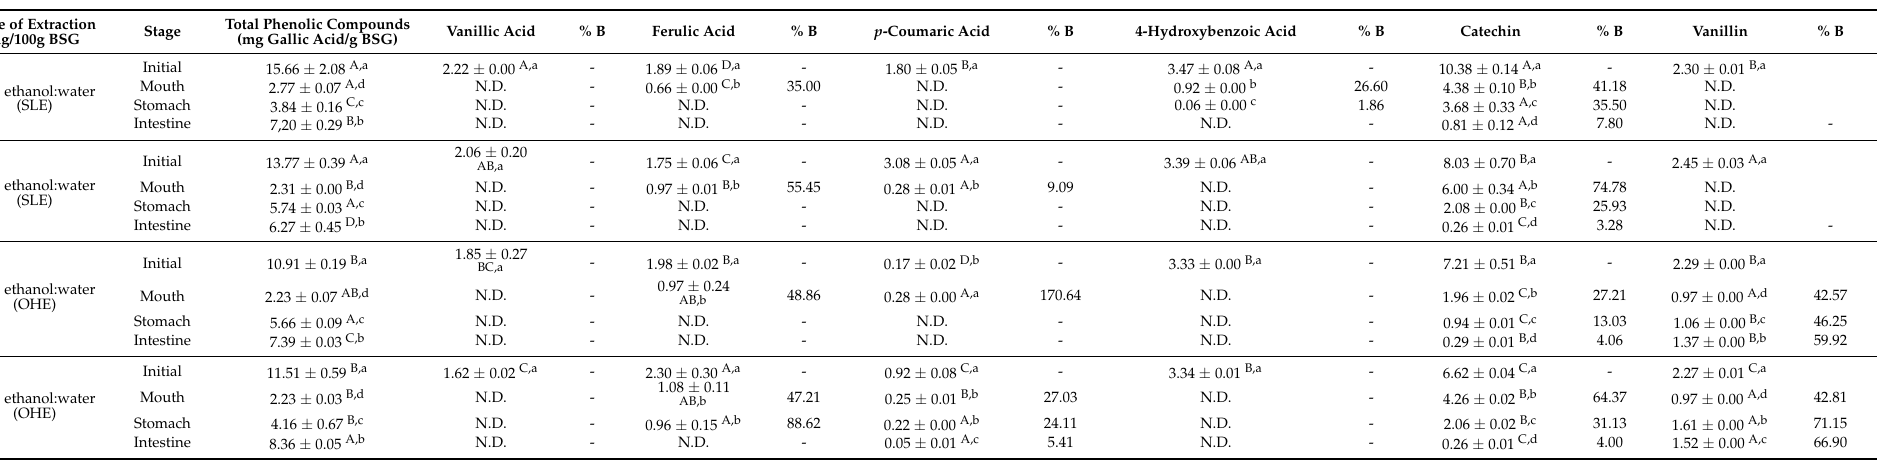
Table 2. Concentration of total phenolic compounds and individual phenolic compounds present in BSG flours obtained after extraction using 60% ethanol:water and 80% ethanol:water (SLE) and 60% ethanol:water and 80% ethanol:water (OHE) of, for the non-digested (initial) and for the three stages of the GID (oral, stomach and intestine) expressed as mg/100 g BSG as well as the total phenolic compounds (mg gallic/g BSG) and bioaccessibility index (mean ±